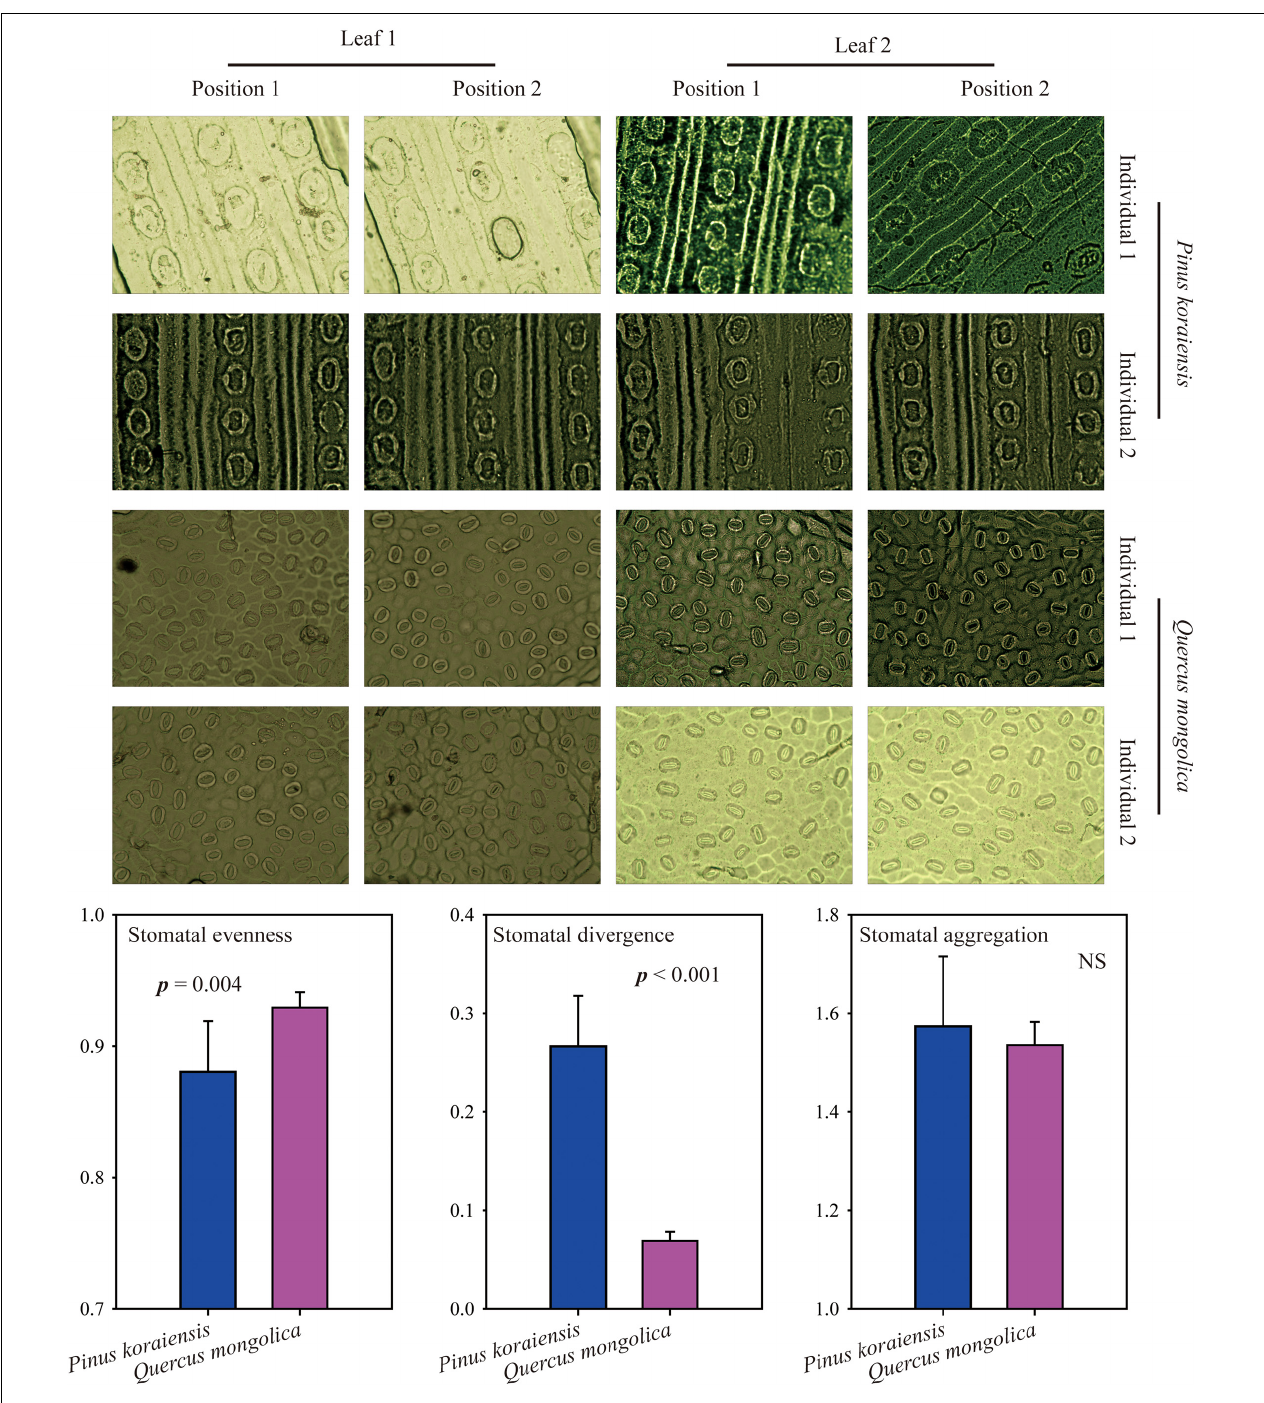
FIGURE 3 | Images of stomata from Pinus koraiensis and Quercus mongolica and their comparisons on stomatal patterning. NS, Not Significant.